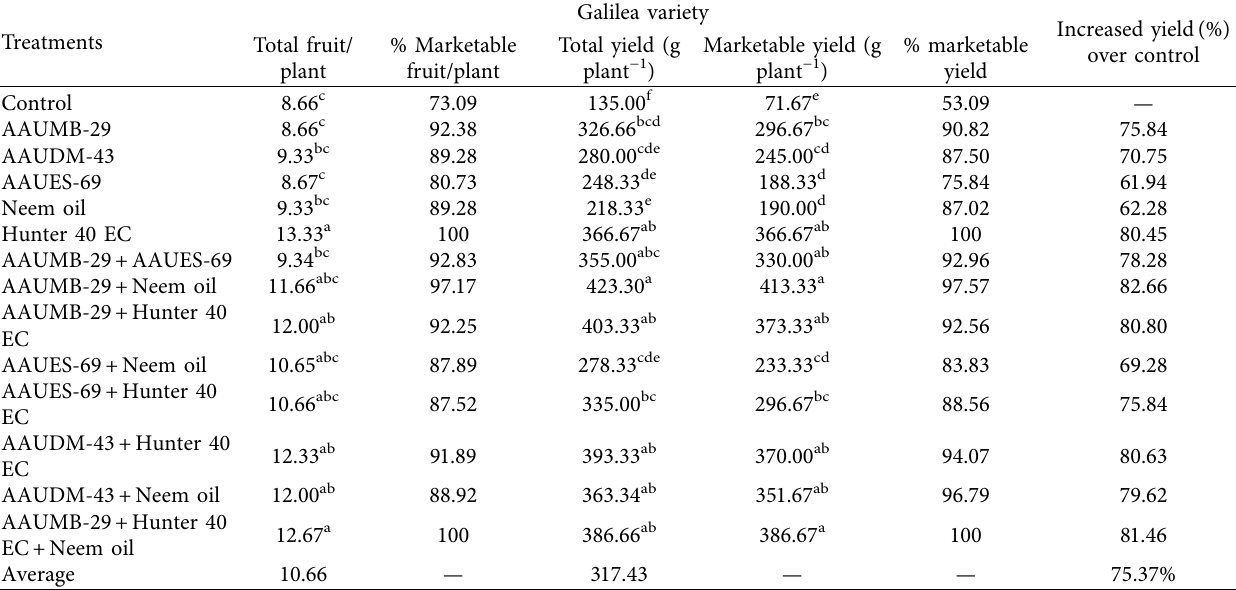
Table 5: The effects of treatments on fruit yield of the Galilea tomato variety under greenhouse.